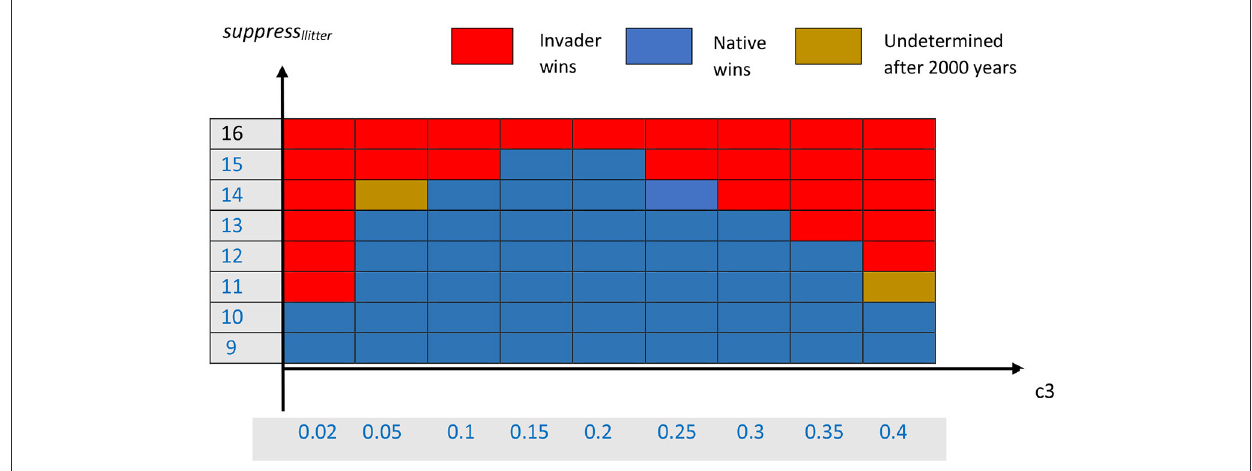
FIGURE2 Bifurcation diagram for competition between the invading and native species. Red indicates that the invader appears to always exclude the native, blue indicates that the native appears to always exclude the invader, and brown indicates that it was not clear, after a long time period, which species would win.